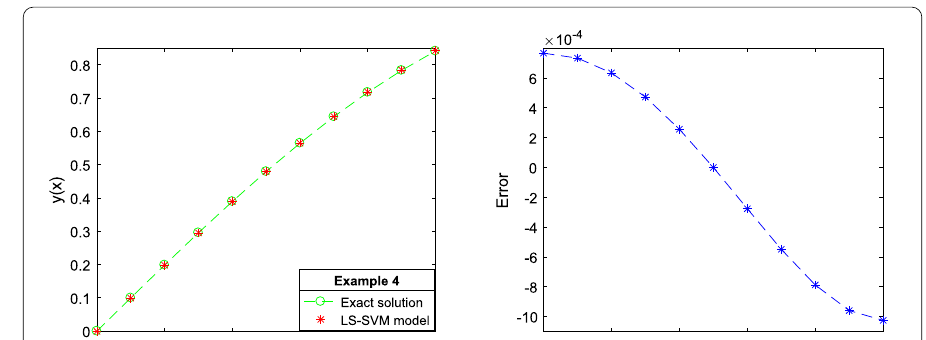
) = sin ( 1 ), y (cid:6) (1) = cos (1). The an- 2 2